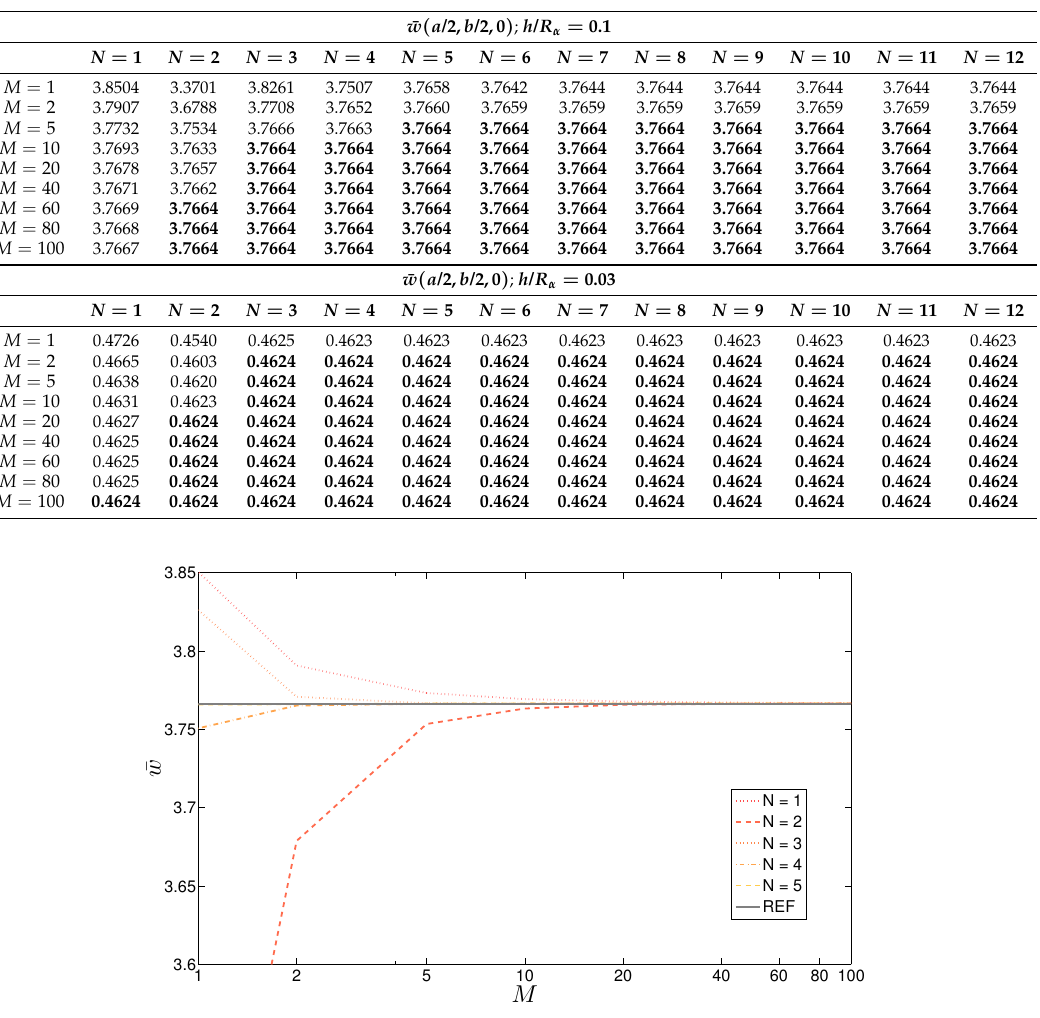
M = 5 mathematical layers with an expansion of the exponential matrix equals N = 5. Figure 7 confirms the trend shown in Table 6 for the displacement ¯ w of the thinner shell: the results move close to the exact value as the order of expansion is increased. Table 6. Case 4. Composite laminated spherical shell. Displacement ¯ w for thickness ratio h / R α = 0.03 and for thickness ratio h / R α = 0.1, both evaluated in the middle and given as dimensionless values. Each physical layer ( N L = 3) is divided into M mathematical layers. 3D reference solution by Fan and Zhang [35].